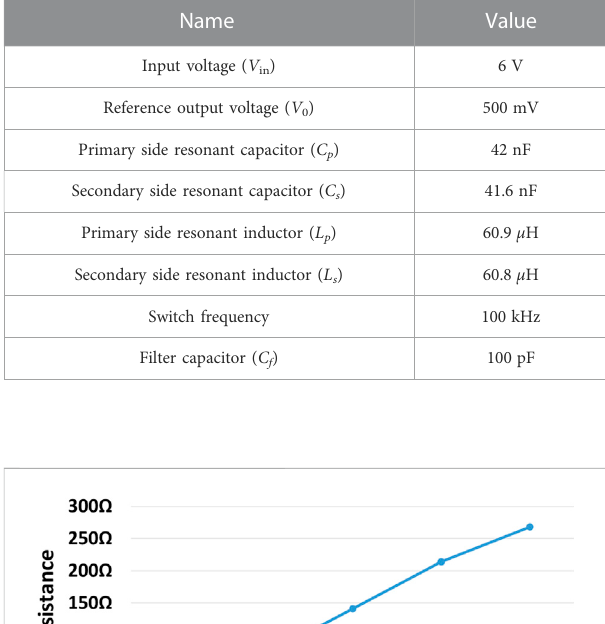
TABLE 5 Parameters in experimental circuit.